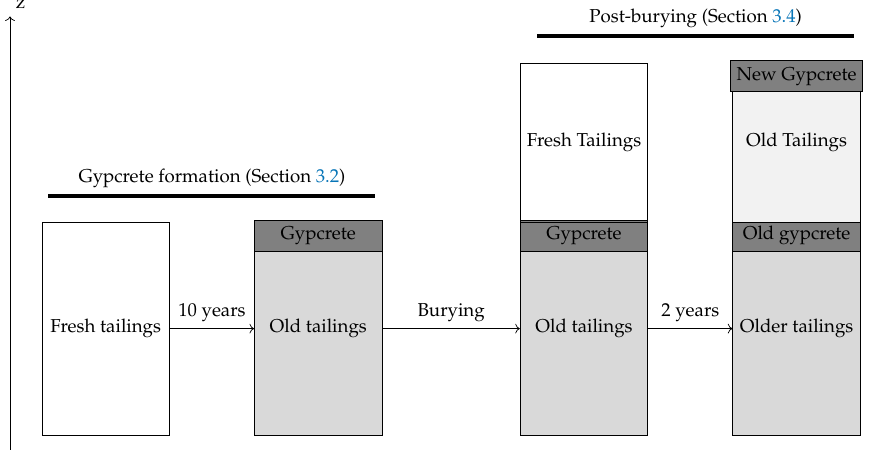
Figure 2. Schematic description of the simulation sequence. First, the formation of the gypcrete is modeled over 10 years (Section 3.2, Figures 4 and 5). Then, a new simulation starts with new fresh tailings on top (Section 3.4, Figures 7 and 8), and the initial condition of the lower domain correspond to results of the simulation presented in Section 3.2. The initial condition for the upper domain (fresh tailings) are the same as that for the simulation of the gypcrete formation (Section